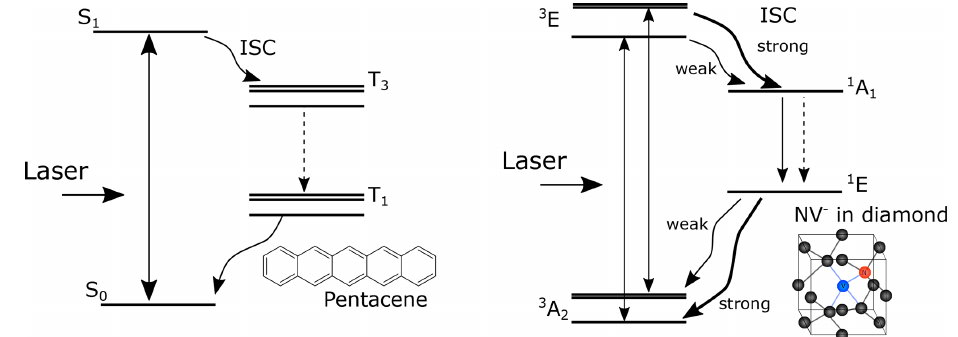
Figure 1. Schematic diagrams of the electronic structure for NV − and pentacene. The optical transitions are denoted by solid straight arrows, the transitions caused by intersystem crossing are denoted by wavy arrows, and the transitions caused by internal conversion are denoted by dashed straight